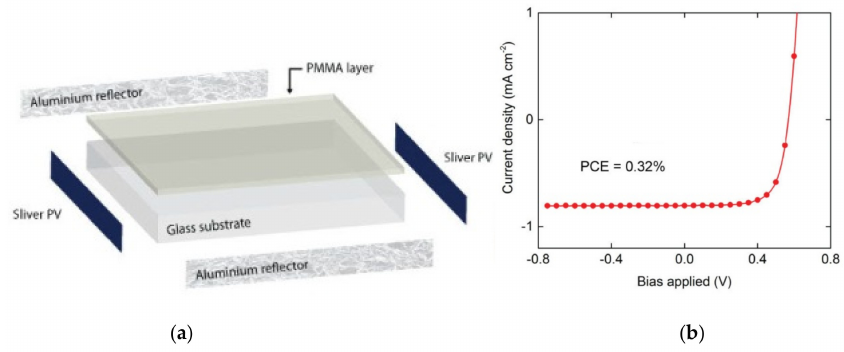
Figure 6. ( a ) Structure of the LDS device; ( b ) Current-voltage characteristics of a transparent planar concentrator device fabricated using 15. (reprinted with permission from ref. [4], Copyright 2017 American Chemical